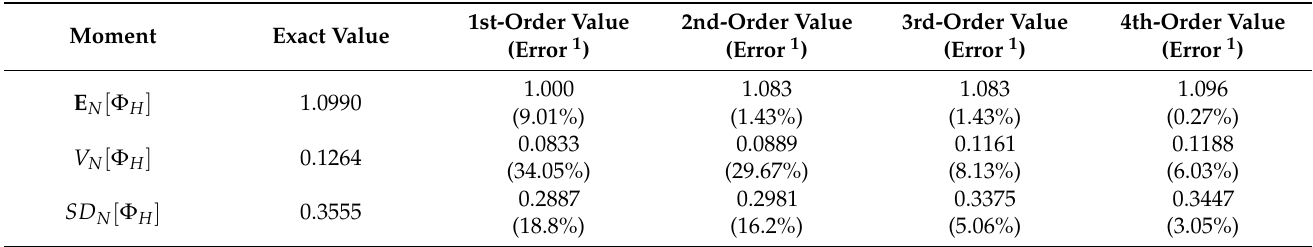
Table 2. Exact and approximate values for the expectation, variance and standard deviation of Φ H ( σ ; E ) for β = 0.5. Moment Exact Value